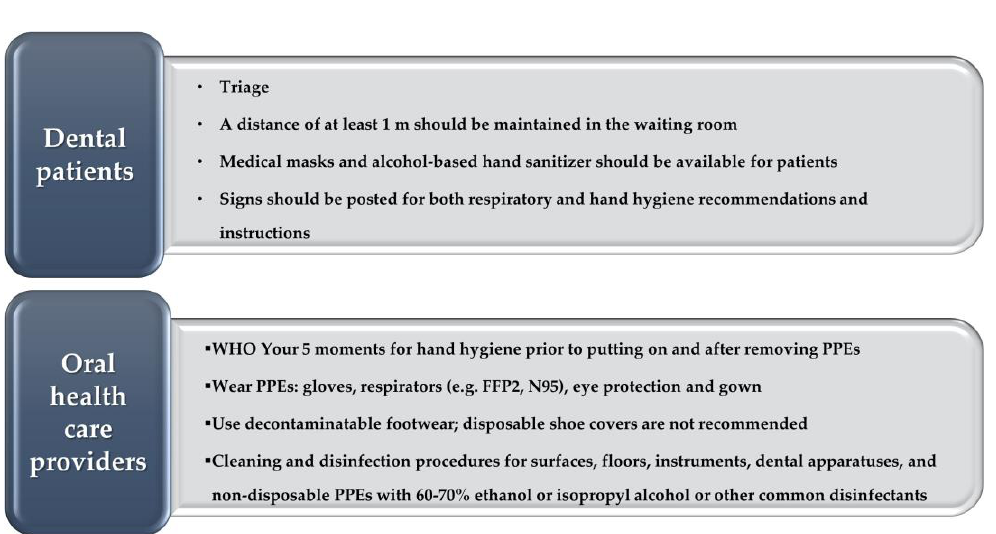
Figure 5. Synthetic recommendations for Prevention and control of Monkeypox infection in dental settings.